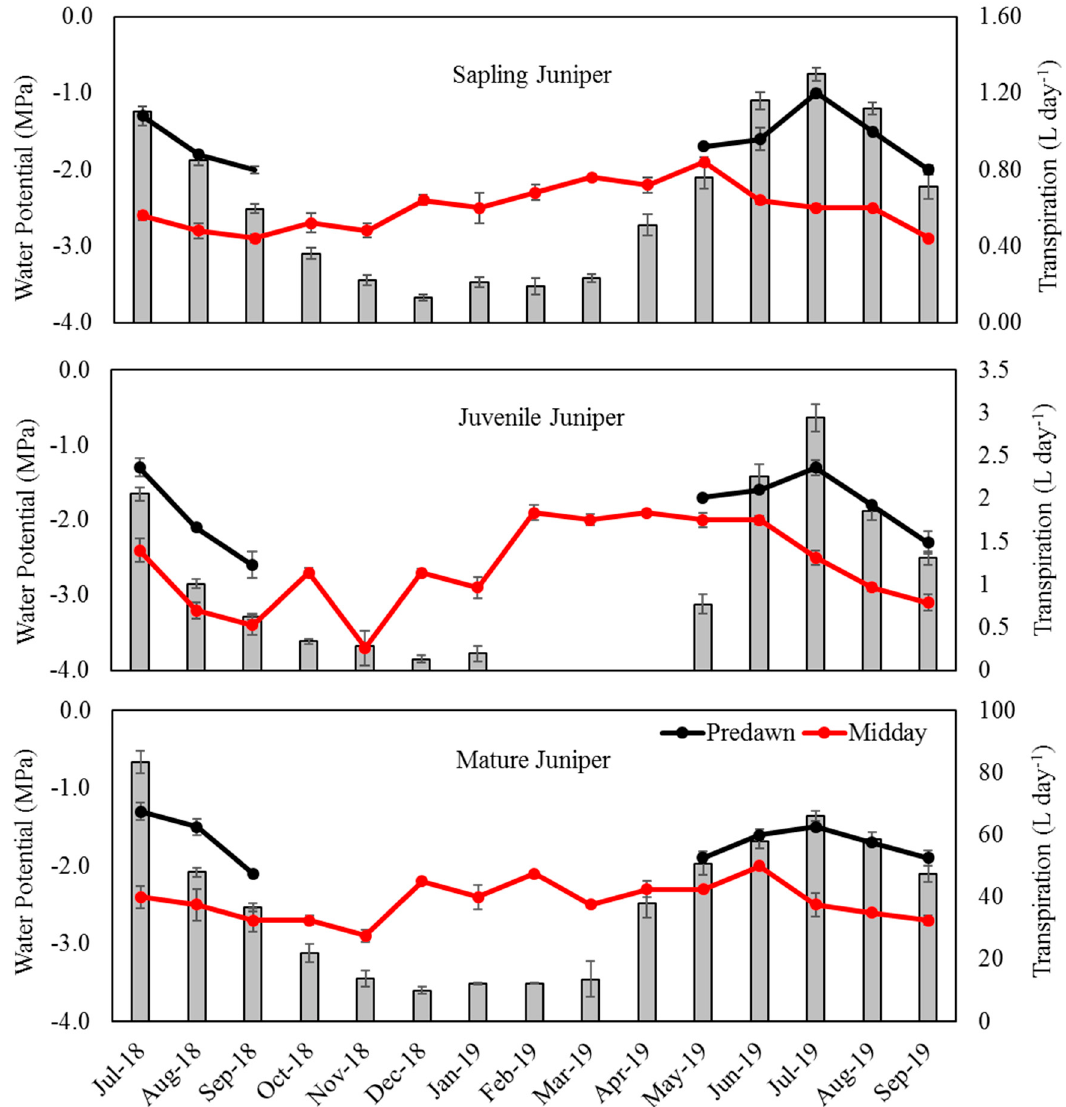
Figure 3. Monthly leaf water potential at predawn (least water stressed) and midday (most water stressed), and transpiration estimate for western juniper growth stages: sapling, juvenile, and mature. Data points are mean ± standard error.